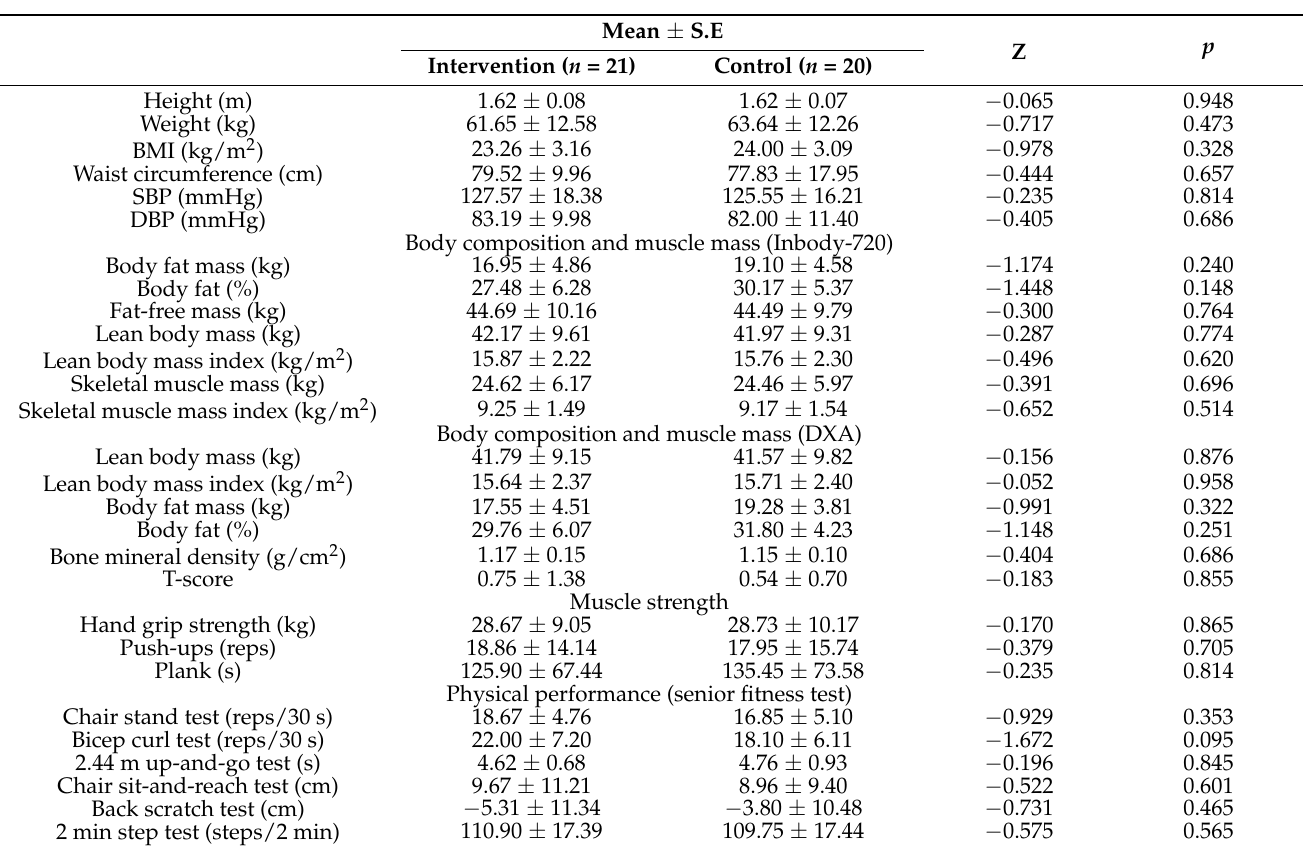
Figure 1. Flow diagram for the study population. Table 3. Baseline characteristics of the